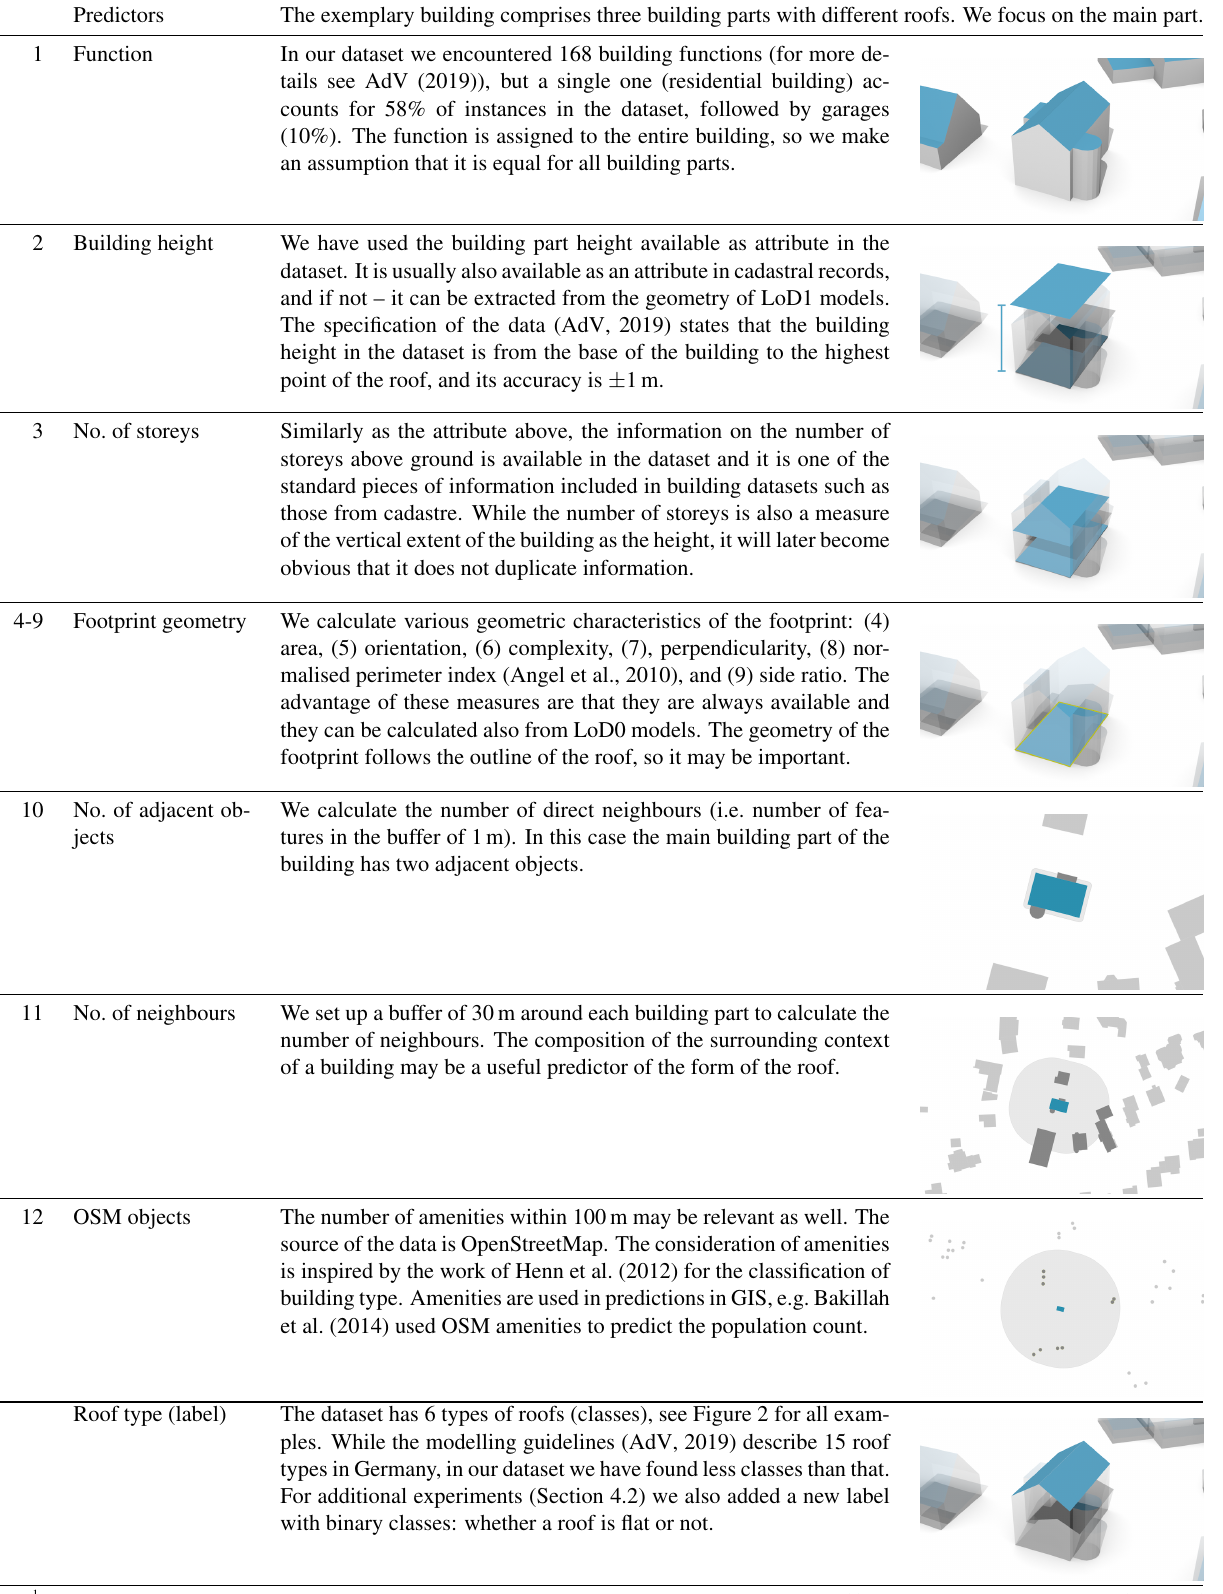
Table 1. Variables in the classification with their description and examples. Source of the open datasets: Hamburg 1 and OpenStreetMap.